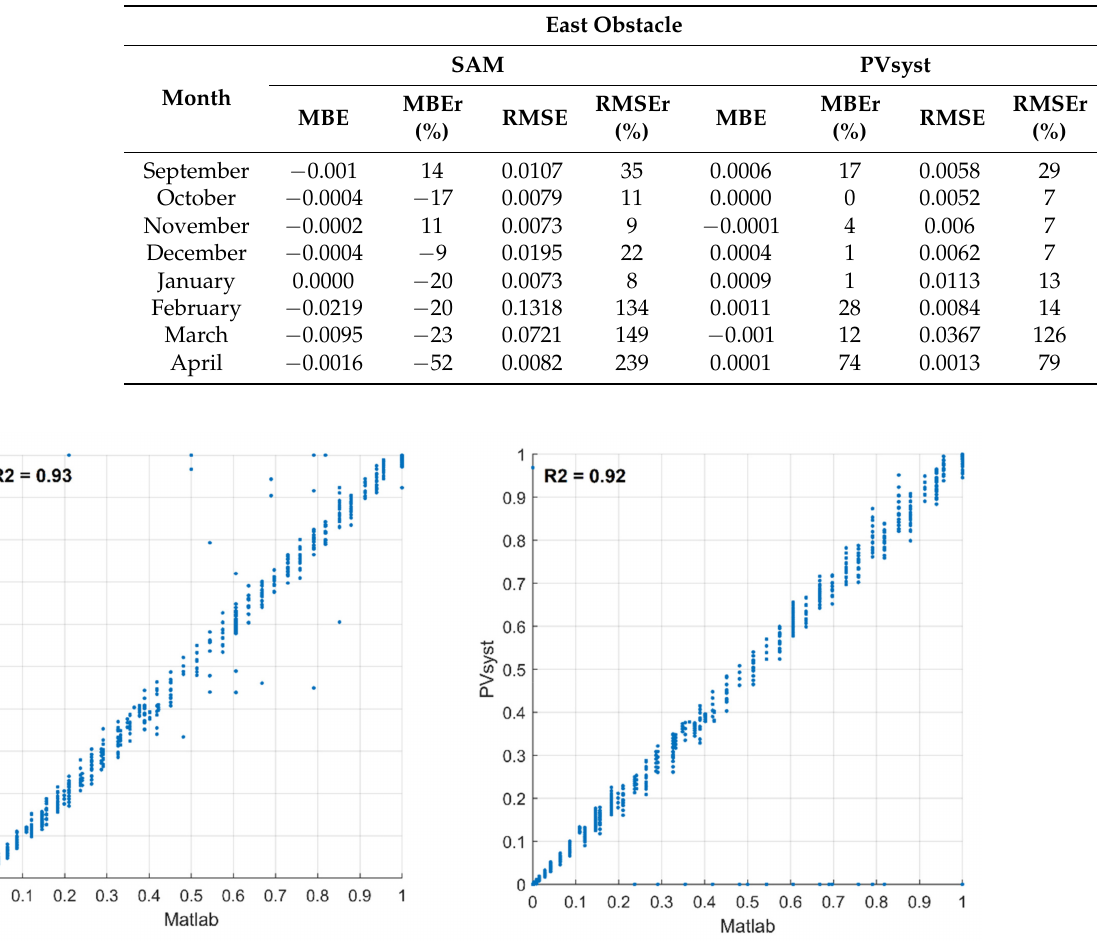
Table 3. Deviation parameters between the Matlab tool, SAM, and PVsyst for situation 1.